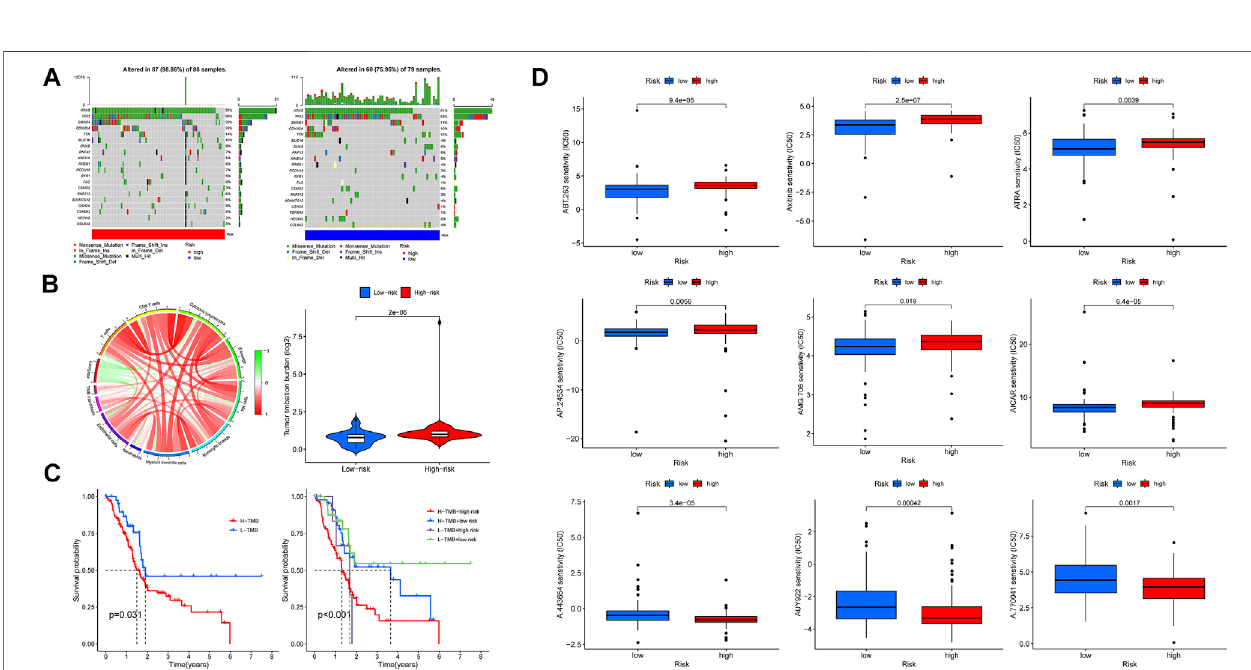
FIGURE 10 | Tumor mutation burden (TMB) and drug sensitivity analysis. (A) Somatic mutation landscape of the high- (left) and low-risk (right) groups. (B) Associationnetworkofriskscores,TMB,andimmunecells.Redreferstopositiverelation,whereasgreenreferstonegativerelation. (C) K-Msurvivalcurveofpatientsat high/low TMB (left), as well as TMB united with risk scores (right). (D) Lower half inhibitory concentration (IC50) of chemotherapeutic agents: the low-risk score was associated with AICAR and Axitinib, while the high-risk score was associated with AUY922.